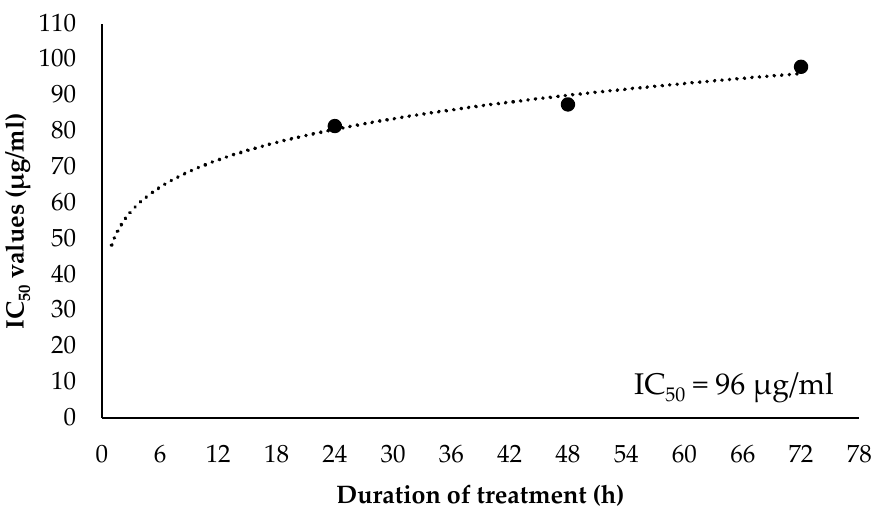
Figure 6. Determination of constant IC 50 value of EO-L in BEAS-2B cell line.